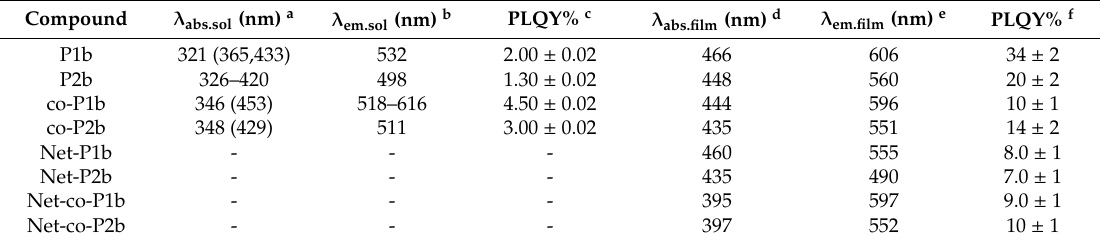
Table 2. Optical data of homo- and co-polymers and the derived